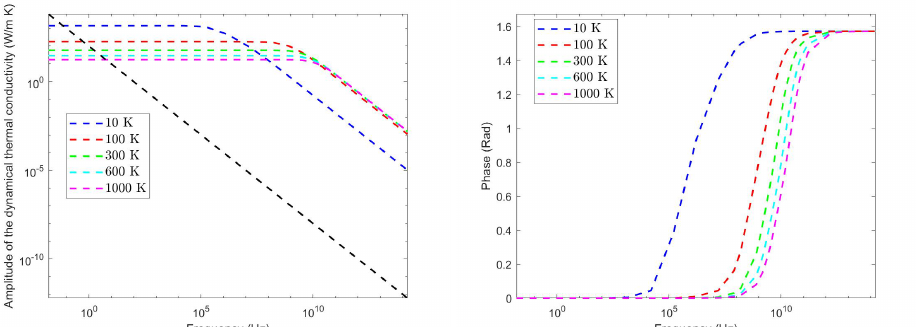
Figure 6. Amplitude ( left ) and phase ( right ) of the Ge dynamical thermal conductivity vs. tempera- ture. The black line behaves like 1/ f .